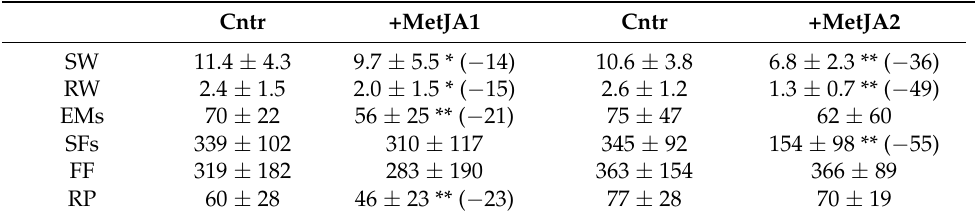
Table 2. Plant growth and infection variables detected 40 days after inoculation with RKN J2s (200 J2/plant), in untreated (cntr) and MetJA-treated tomato. MetJA was applied to plants by foliar spray. Tomato plants were treated with two ranges of doses (expressed as mg MetJA g − 1 plant fresh weight at treatment): MetJA1 1.0–2.5, MetJA2 6.5–8.3. Plant growth was assessed by shoot (SW) and root weights (RW) expressed in grams; nematode infection severity was indicated by egg mass per root system (EMs), sedentary forms per root system (SFs), female fecundity (FF), and reproduction doses (MetJA2) were toxic to plants. potential (RP). Mean values ± standard deviations obtained from untreated and MetJA-treated tomato plants are differentiated by a paired t -test (* p < 0.05; ** p < 0.01). In parentheses, significant differences are expressed in